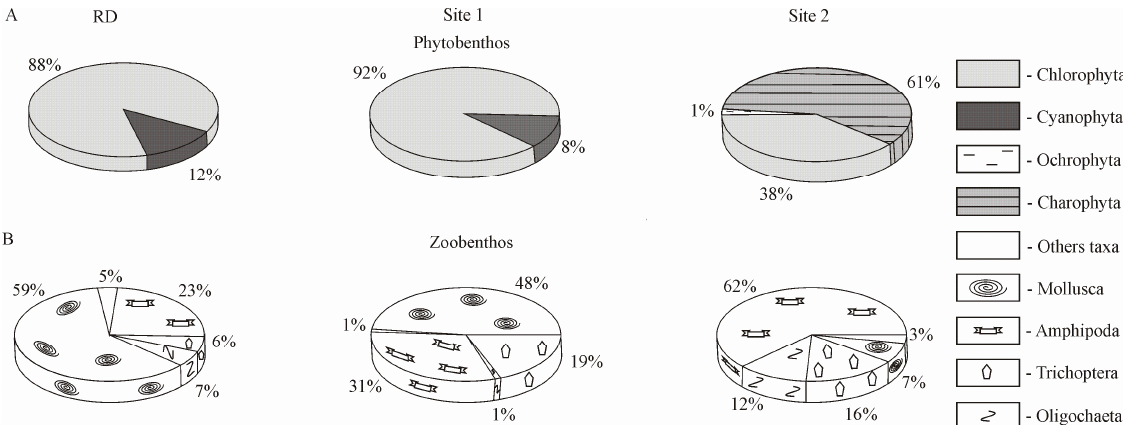
Figure 6. The proportion of higher taxa in the formation of the total benthic biomass in the studied areas of the Baikal coastal zone. ( A ) Percentage ratio of the biomass of macroalgae higher taxa; ( B ) percentage ratio of the biomass of macrozoobenthos higher taxa. RD—reference data include samples collected on the stones from 0 to 5 m depth range in the north-western direction 5 and 17 km off Listvennichny Cape in the past century. Site 1 included stations at transect 1 of the background area in 2016; site 2 included stations at transect 2 of the area with human activity in 2016 (see Figure